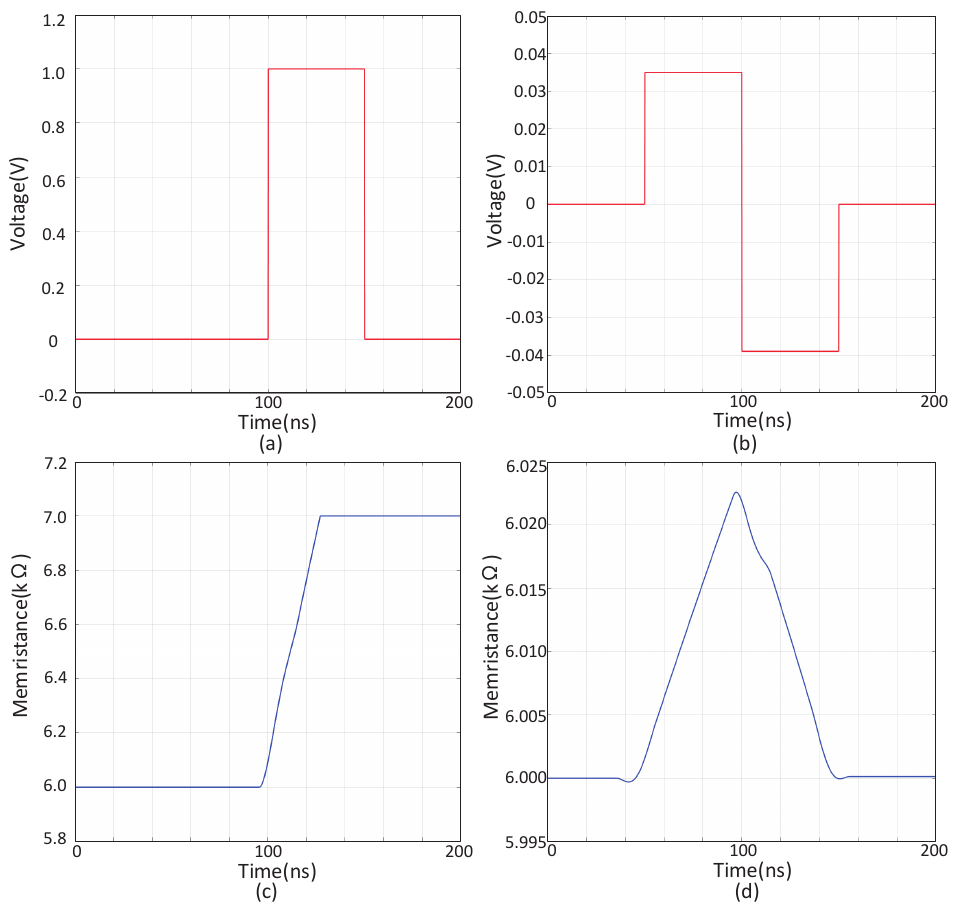
Figure 10. Write, read and restore operations of a charge-controlled spin memristor. ( a ) Write voltage pulse, ( b ) Read voltage pulse, ( c ) Write memristance value, ( d ) Read memristance